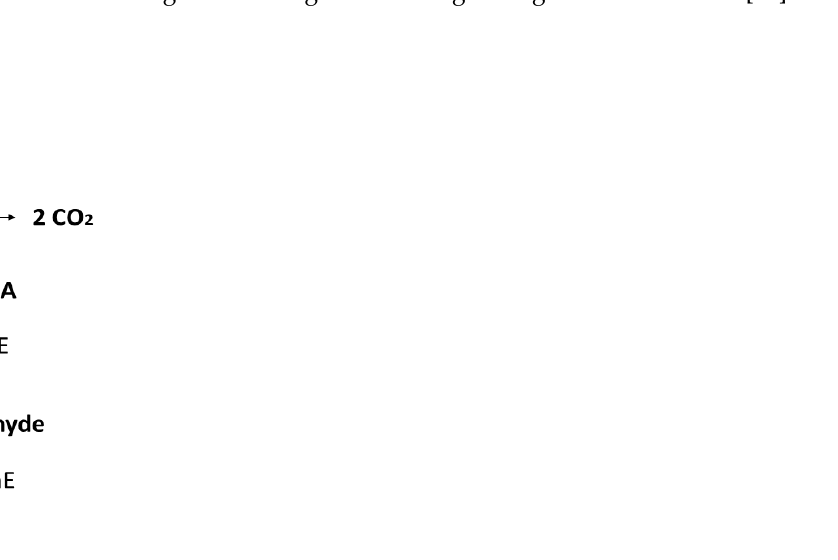
Figure 3. Ethanol formation from glucose in bacteria. AdhE—bifunctional CoA-dependent ethanol/aldehyde dehydrogenase.